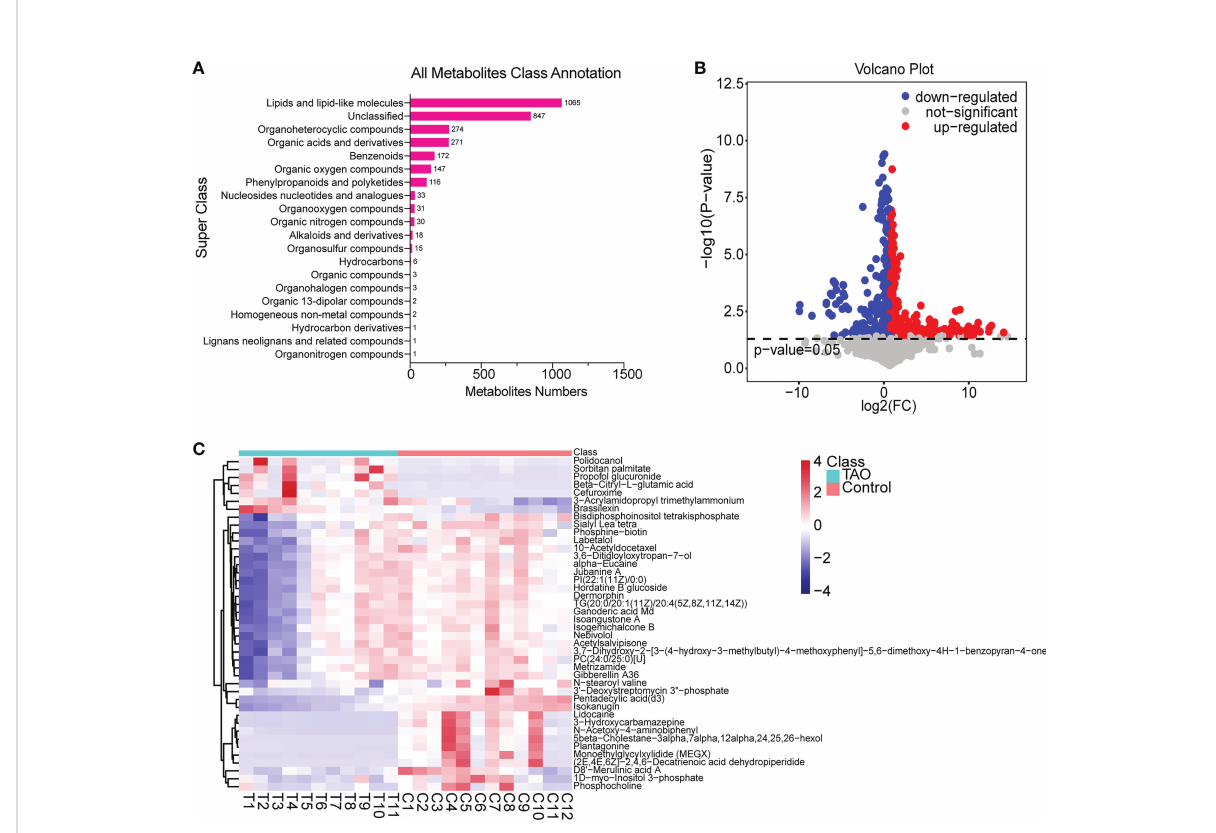
FIGURE 2 Overview of changed metabolites. (A) Class annotation of the changed metabolites. (B) Volcano plot of changed metabolites. (C) Heat map of 42 changed metabolites (VIP scores > 1, P <